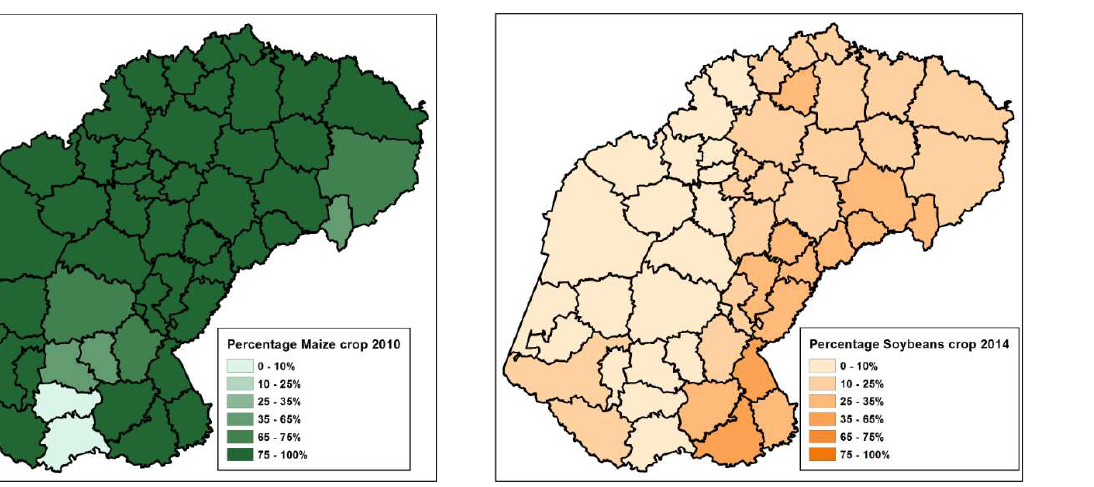
Figure 7. Calculated percentage of maize from other cultivated crops in 2010